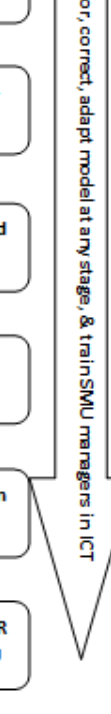
Fig. 1. Robust SMU KB model for